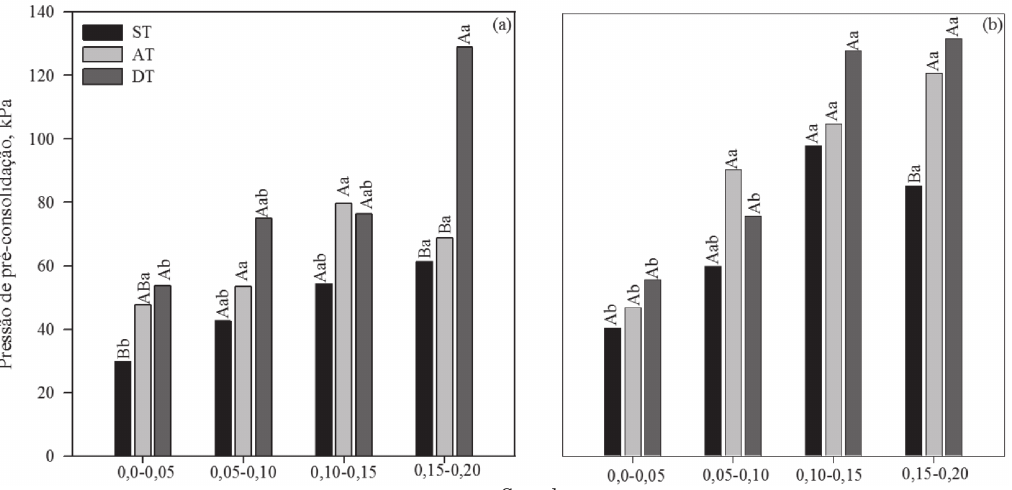
Figura 4. Pressão de pré-consolidação nos sistemas de manejo pousio (a) e aveia + ervilhaca (b), nas condições de sem tráfego (ST), antes do tráfego (AT) e depois do tráfego (DT), em camadas. Letras iguais não diferem significativamente pelo teste de Tukey (p<0,05). Letras maiúsculas comparam condições de tráfego em cada camada e minúsculas, camadas em cada condição de